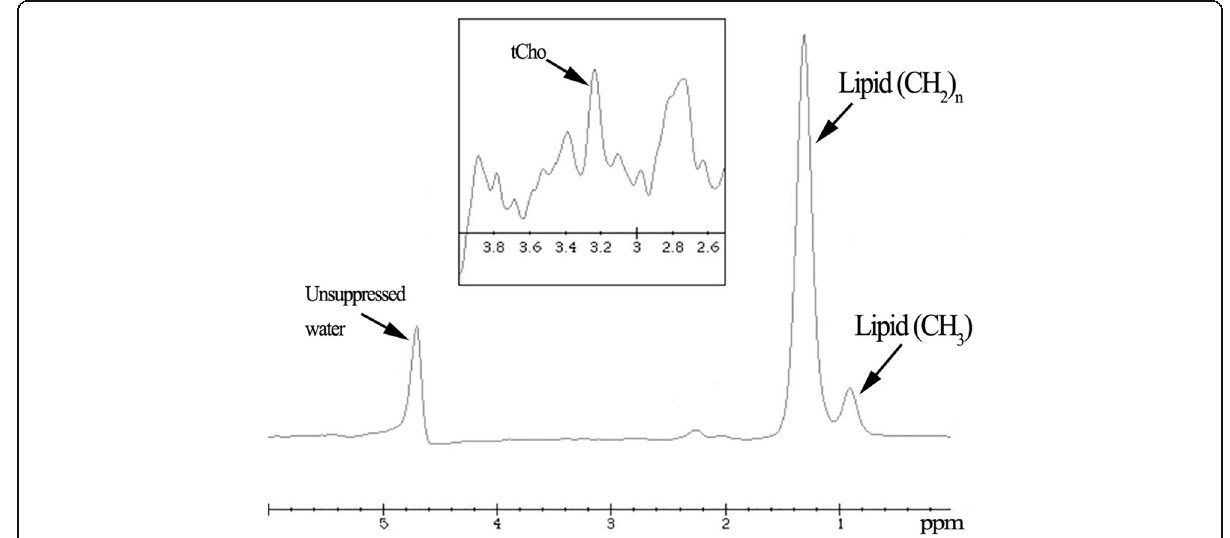
Fig. 2 1 H-MRS of the breast gland in a healthy fertile 26-year-old woman using oral contraceptives. A clear peak of choline-containing compounds (tCho) is visible at about 3.2 ppm, giving an absolute concentration of 0.1 mM Three main resonances are visible at about 0.9 ppm and 1.2 ppm due to lipids as well as at about 4.7 ppm due to unsuppressed